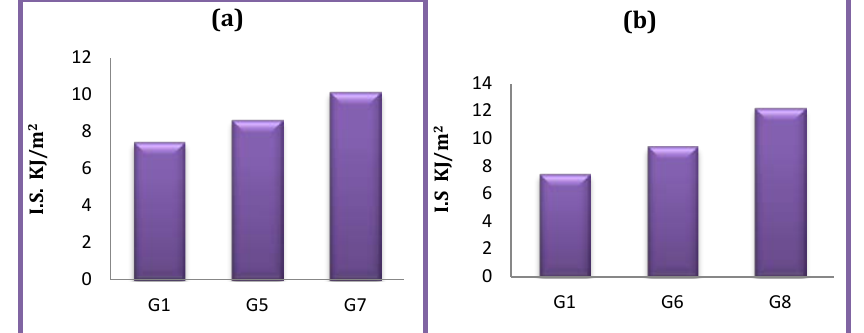
Fig. 5: I.S. of samples prepared by chopped C.F Coated with (a) Al